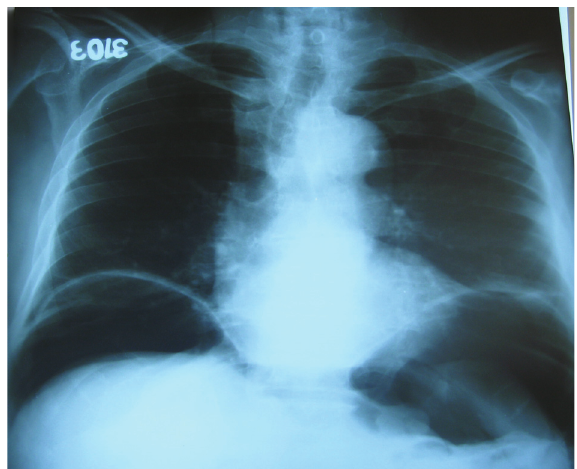
Figure 1: Chest radiography with free intra-abdominal air with elevated left and right hemidiaphragm.